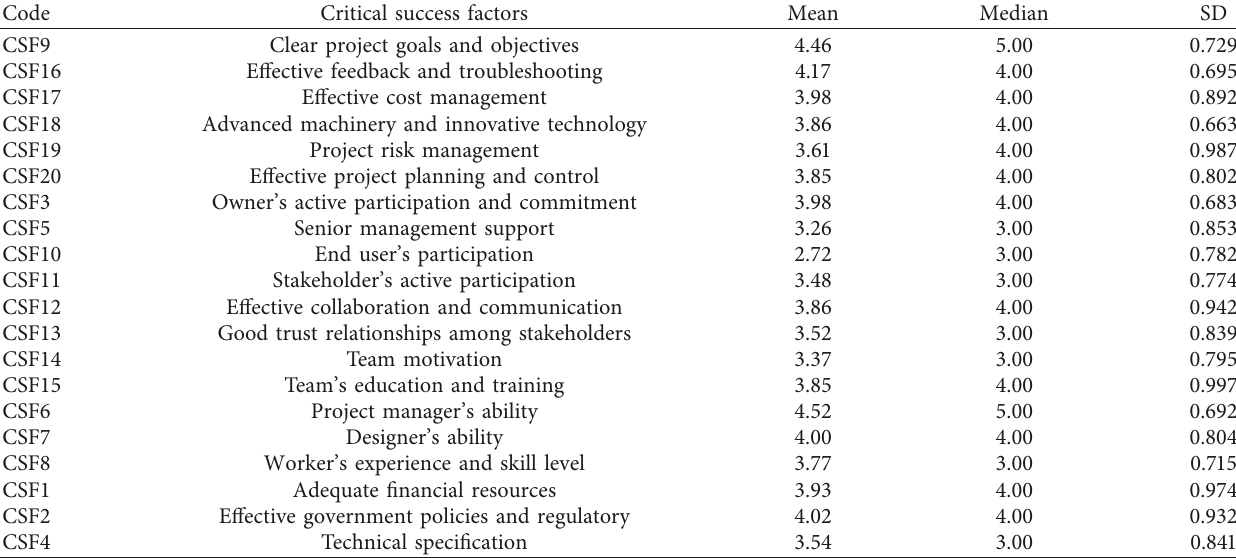
Table 3: Mean, Median, and SD of critical success factors.